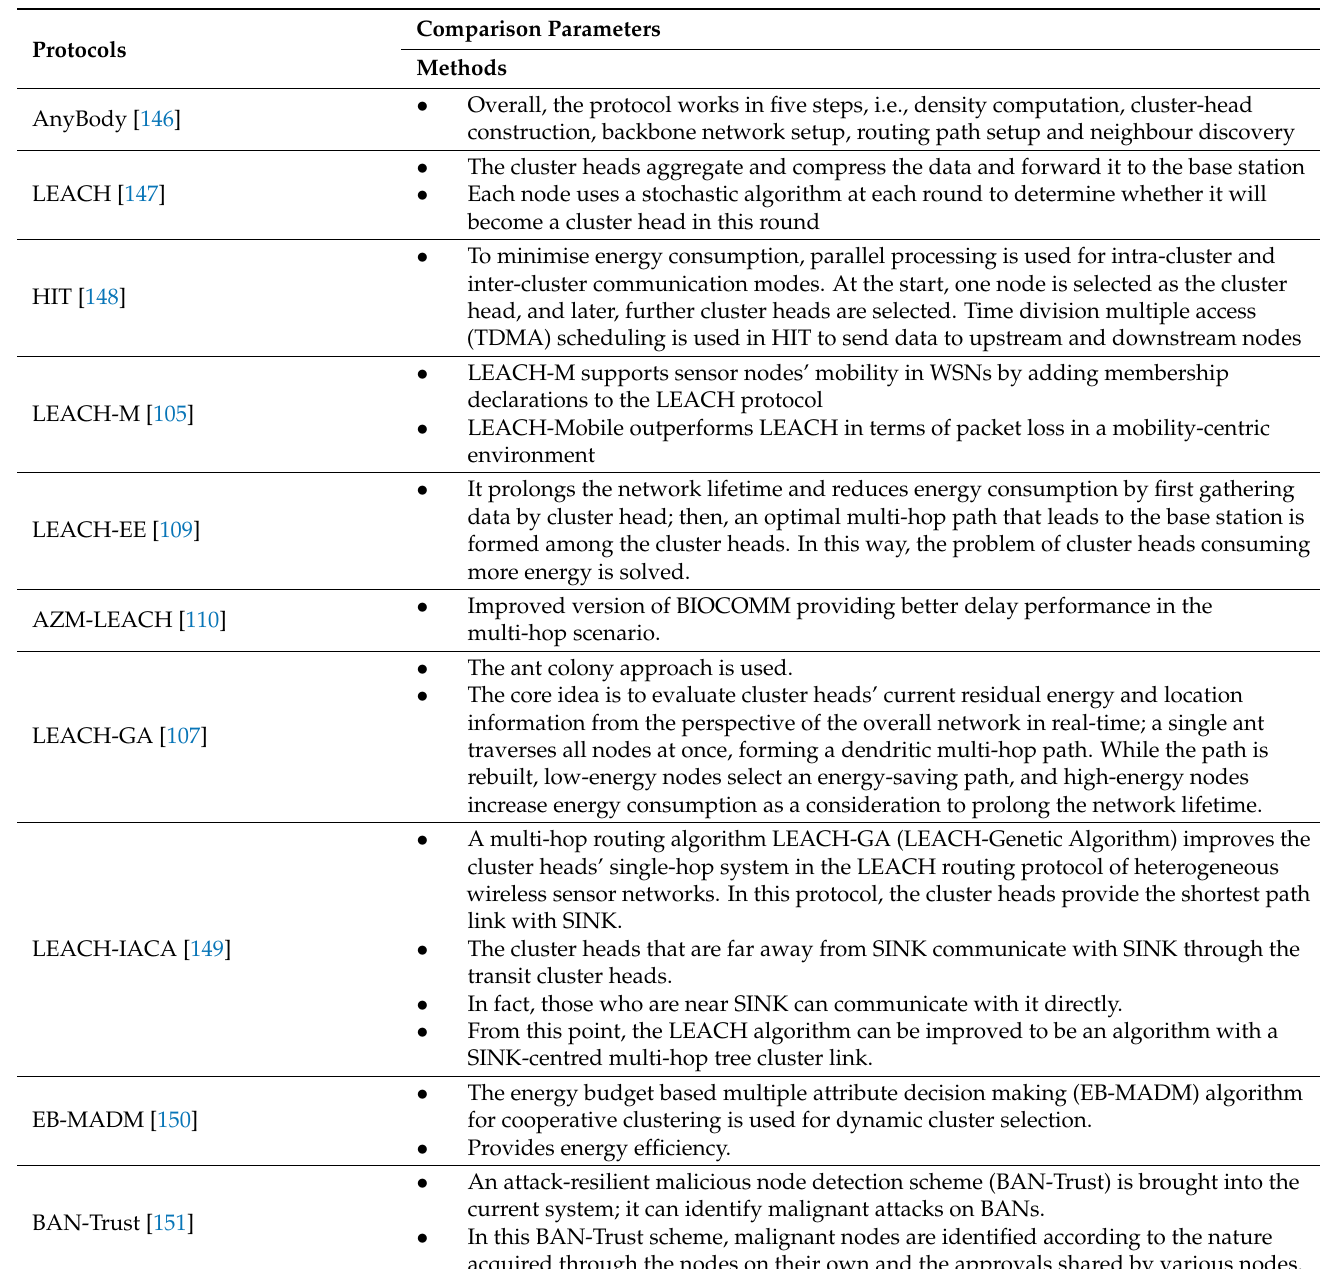
Table 11. Comparative analysis of cluster